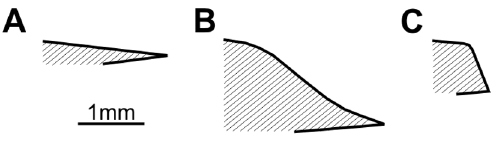
Figure 3. Projections of hole margins at vertical cross